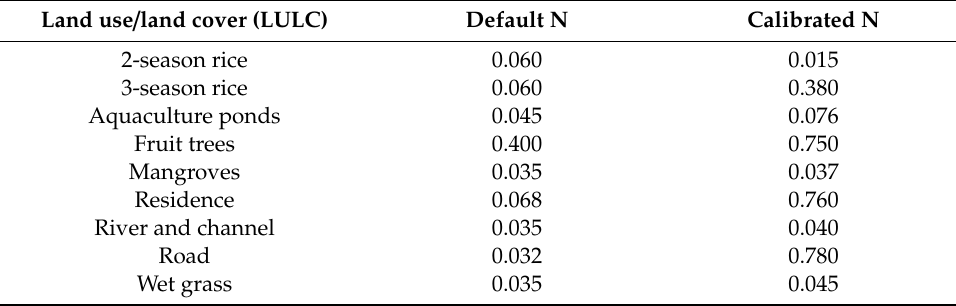
Table 1. Manning’s n roughness coe ffi cients